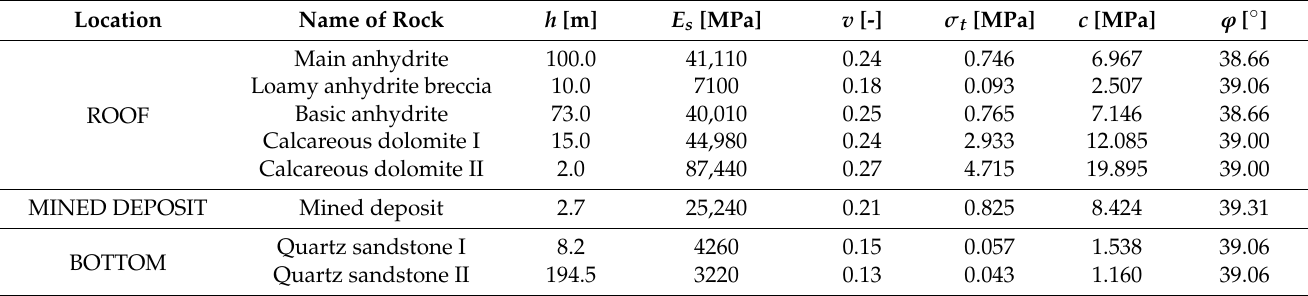
Table 2. Parameters of rock mass assumed for numerical